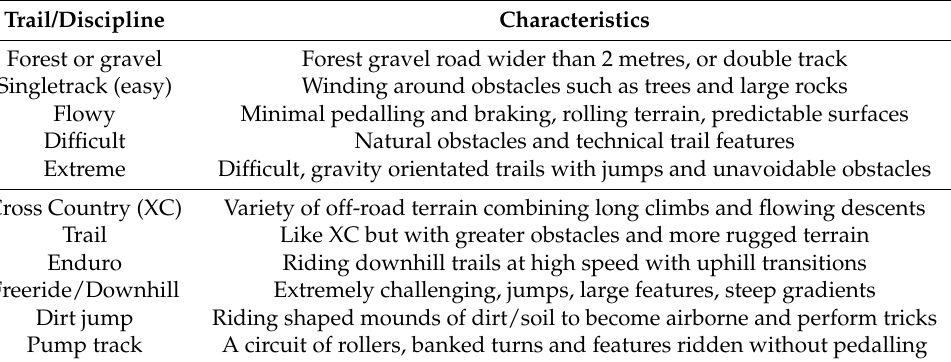
Table 1. Categorisation of trail typologies included in the survey. Trail/Discipline Characteristics Forest or